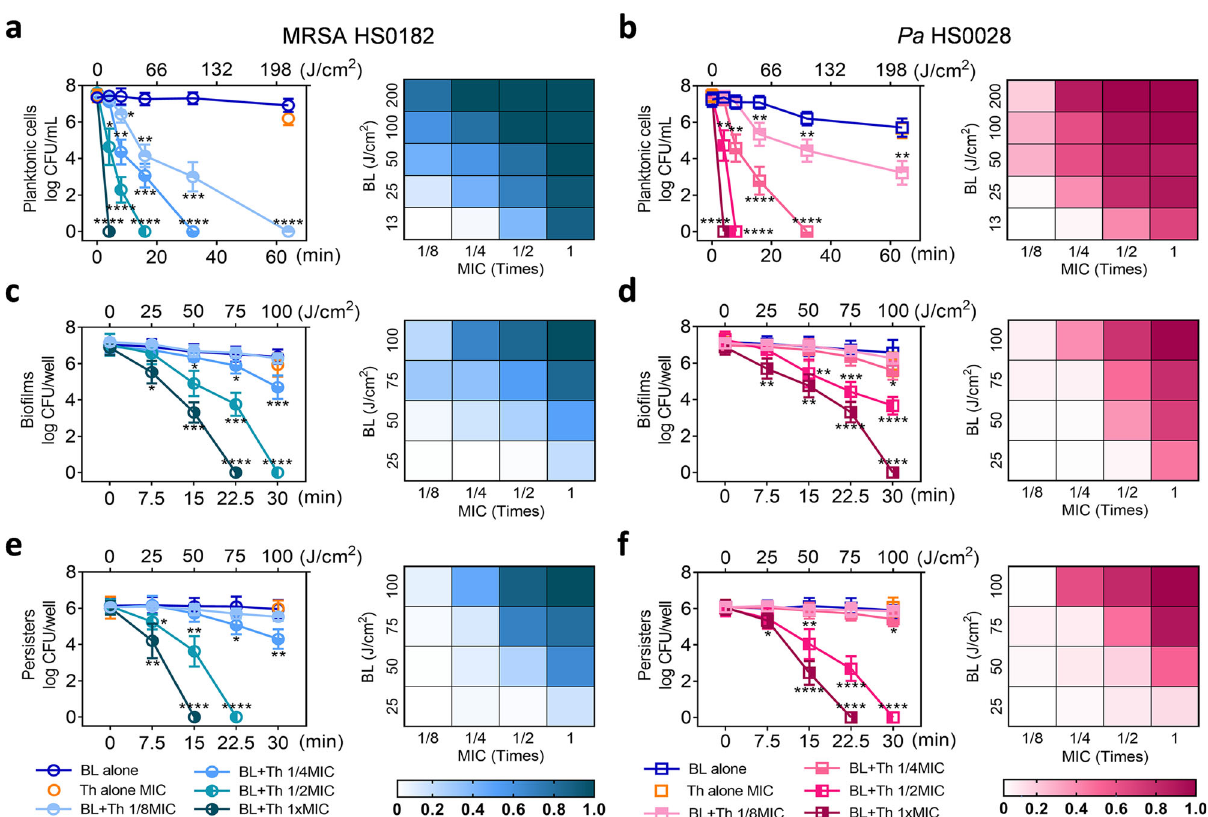
Fig. 2 BL and thymol synergistically inactivate planktonic cells, established bio fi lms, and bacterial persisters. Killing curves (left) and synergy evalution heat map (right) of MRSA HS0182 ( a , c , and e ) and Pa HS0028 ( b , d , and f ) in planktonic cells ( a and b ), established bio fi lms ( c and d ), and bacterial persisters ( e and f ) treated with an increasing BL fl uence alone, thymol at 1x MIC alone, or BL combined with an increasing concentration of thymol (a fraction of MIC). Checkerboards in the corresponding right panels show S -values for different combinations of BL and thymol as assessed by the Bliss Independence model according to the following formula: S -value = (logCFU/mL BL /logCFU/mL Control )(logCFU/mL Th /logCFU/mL Control ) − (logCFU/mL BL + Th /logCFU/mL Control ). LogCFU/mL BL , logCFU/mL Th , logCFU/mL BL + Th , and logCFU/mL control are the number of viable bacteria remaining after treatment with BL alone, thymol alone, combination of BL and thymol, or sham light, respectively. 0< S <1 indicates a synergistic interaction, whereas S <0 indicates an antagonistic interaction. Results are presented as mean±SD of four to six replicates from fi ve independent experiments. **** P <0.0001; *** P <0.001; ** P <0.01; * P <0.05; and ns, no signi fi